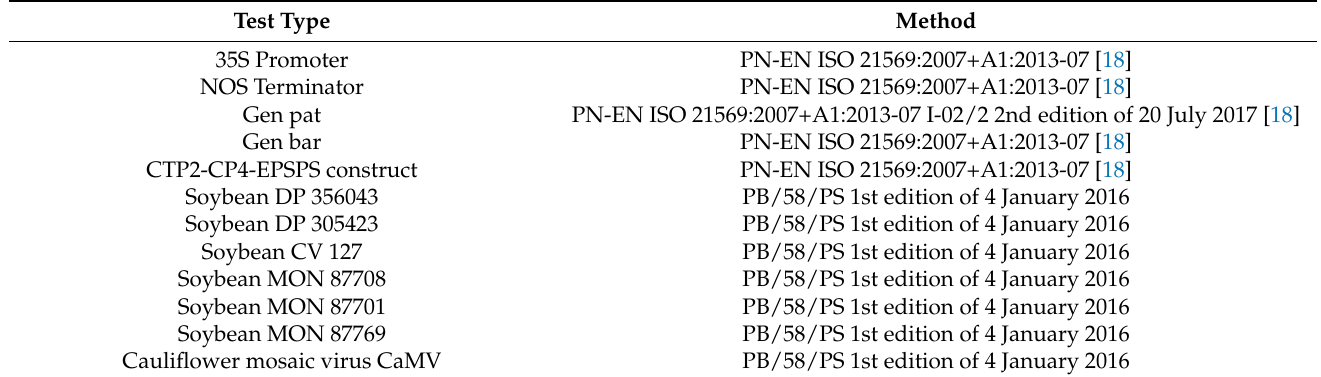
Table 1. The analyses of soybean seeds for genetic